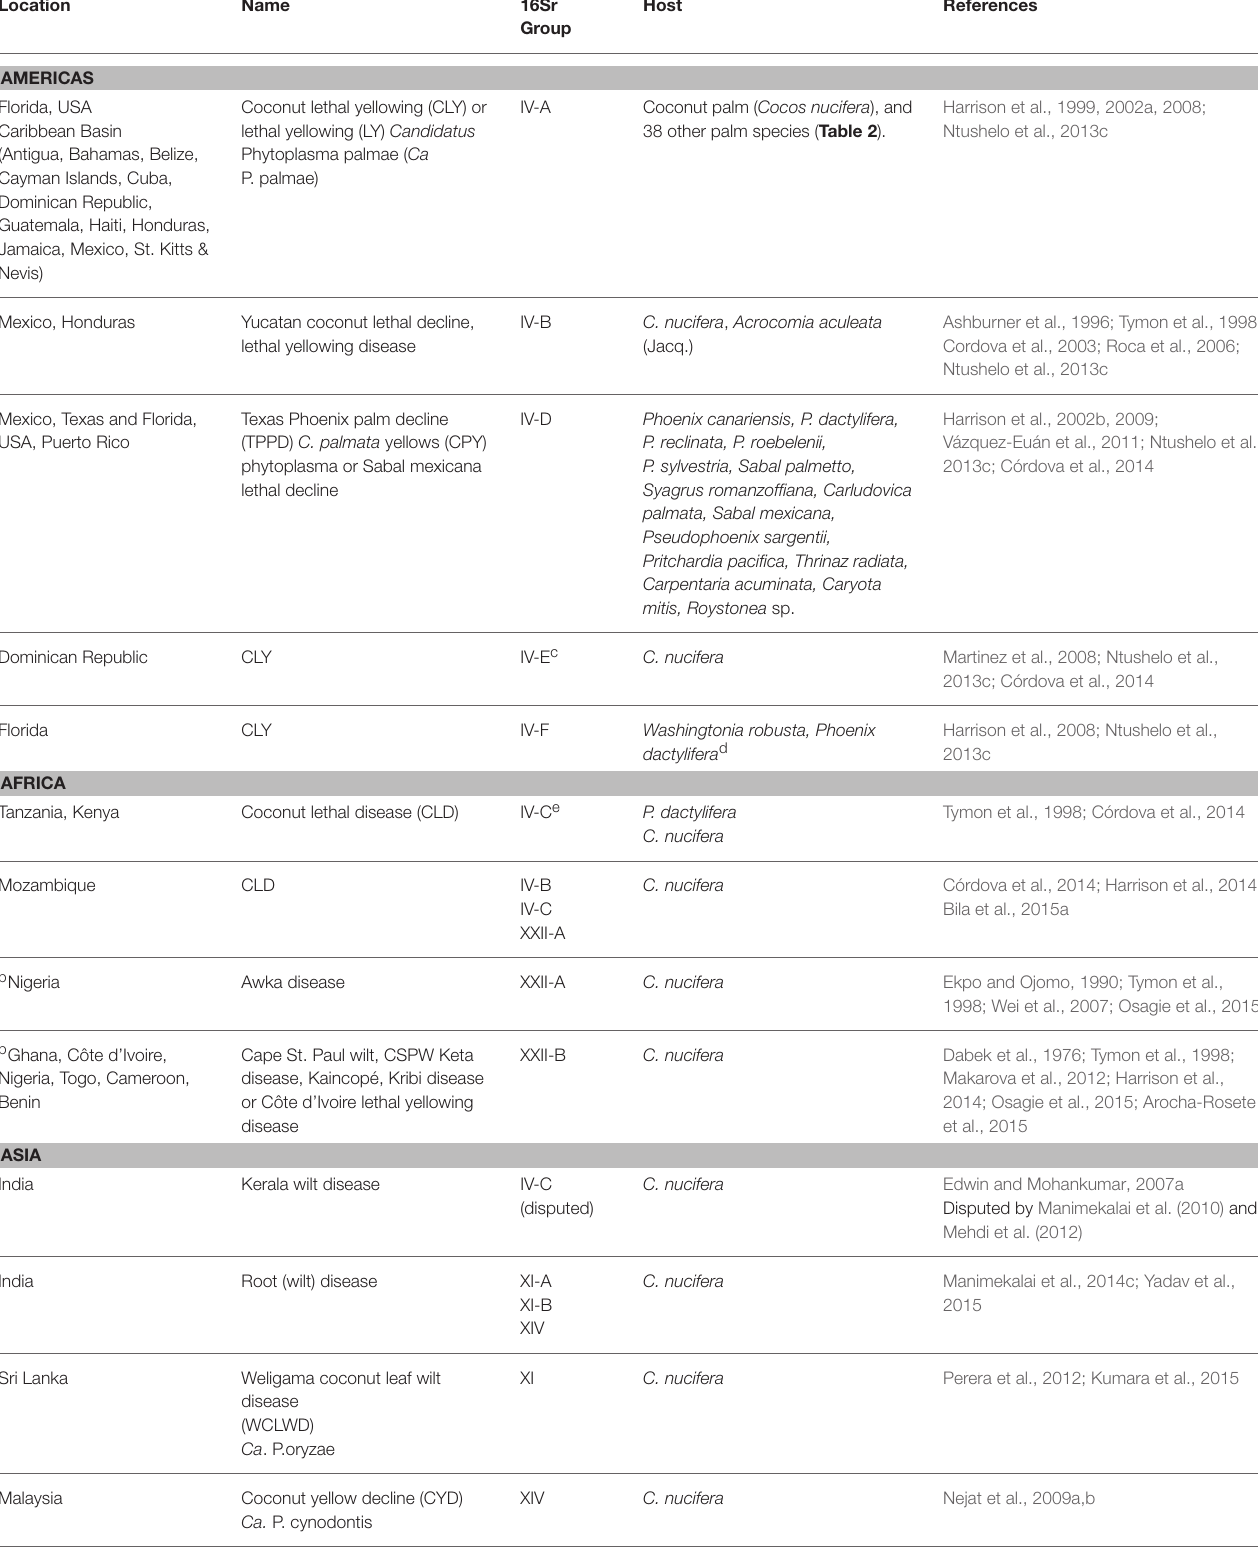
TABLE 1 | Current distribution and range of lethal yellowing-type diseases of palms a .